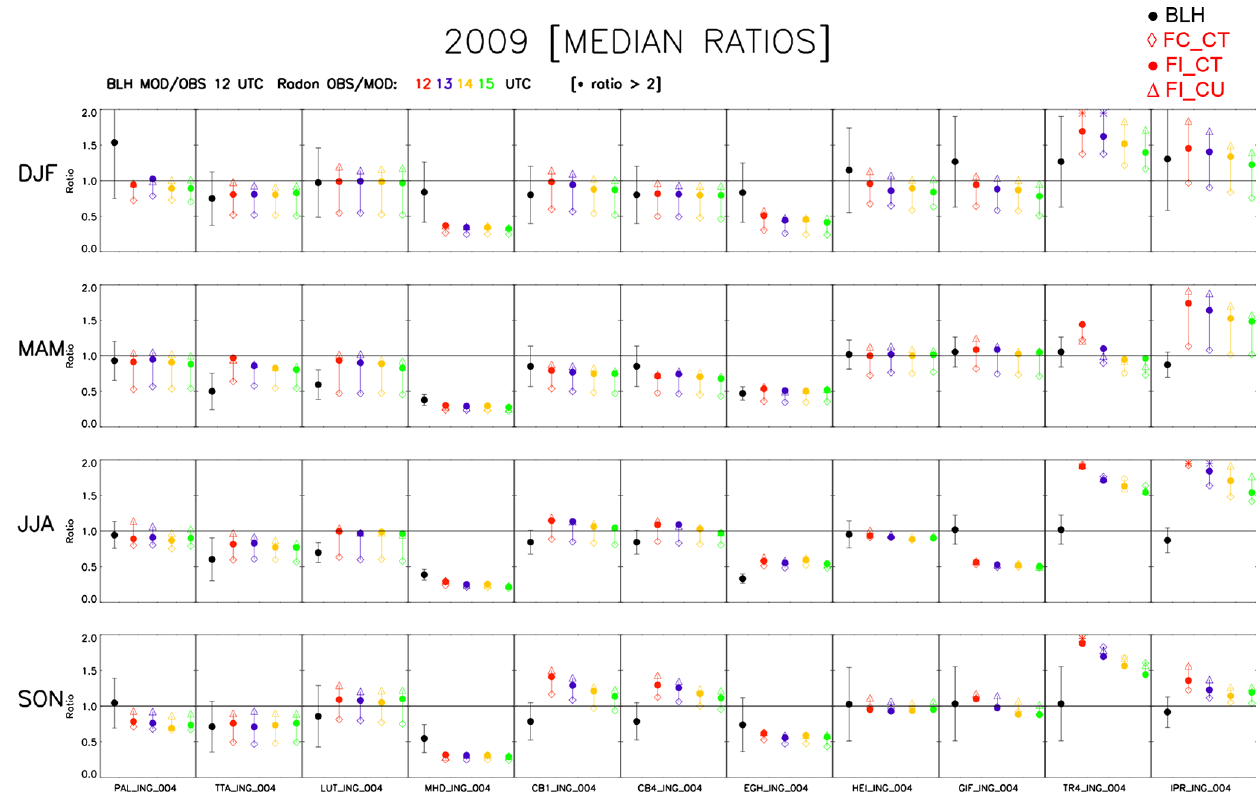
Figure 10. The seasonal variations of the ratios of BLHs (TM5/IGRA; black dots with error bars) at 12:00UTC and the ratios of 222 Rn activity concentrations (OBS/TM5) at 12:00, 13:00, 14:00, and 15:00UTC for the four seasons (DJF, MAM, JJA, and SON) of the year 2009 for all InGOS 222 Rn measurement sites. The closest IGRA station to the radon measurement site is considered (see Fig. 1). Three TM5 simulations are shown here: the model simulations using the constant emissions (FC_CT; coloured diamond), InGOS emissions and using the default convection scheme of TM5 (FI_CT; coloured filled circles), and using the new convection scheme (FI_CU; coloured